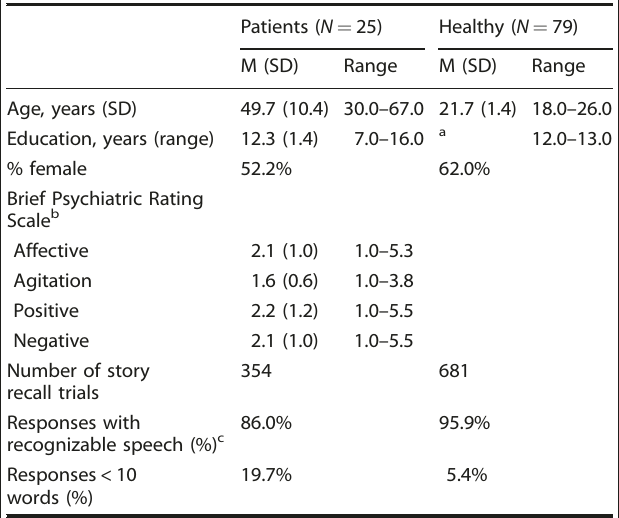
Table 1. Description of participants and story recall